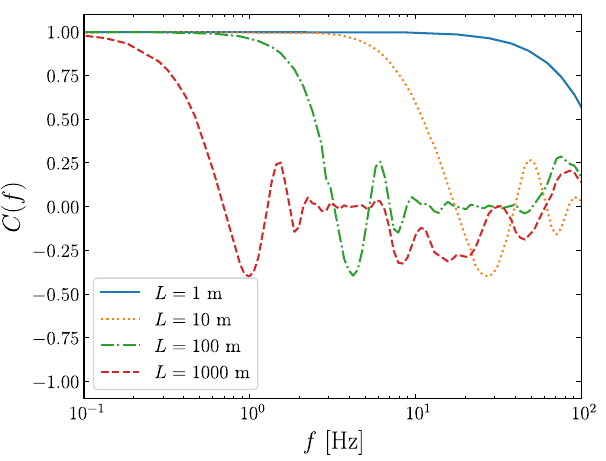
FIG. 11. Correlation C ð f Þ vs frequency f of ground motion model D for different separations L .